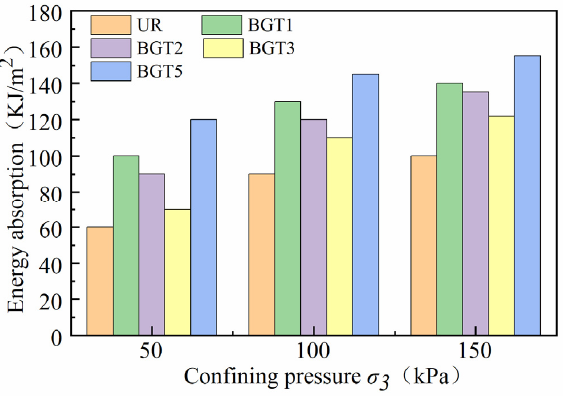
Figure 12. Energy absorption of geogrid reinforced track bed. The effect of different confining pressures and different locations of the waste tyre reinforced track bed layer on energy absorption is shown in Figure 13. The waste tyre reinforcement was significantly different from the geogrid, with the smallest energy ab- sorption across the ballast when T5 reinforcement was applied. Because the waste tyres were composed of flexible rubber material, the maximum number of T5-reinforced tyres resulted in a smaller stiffness of the track bed samples, so the minimum amount of energy was required for the deformation of the track bed. The energy absorption of T2 reinforce- ment was better than that of T1 and T3 when compared to T2 and T3 under 50 kPa, 100 kPa and 150 kPa circumferential pressure. The deformation required to absorb energy was increased by 70.8%, 40% and 55% for T2. The T2 tyre provides additional restraint and frictional resistance; in addition, the T2 tyre reinforcement leads to an increase in the stiff- bed layer and the bed deformation under static load requires the greatest energy absorption.